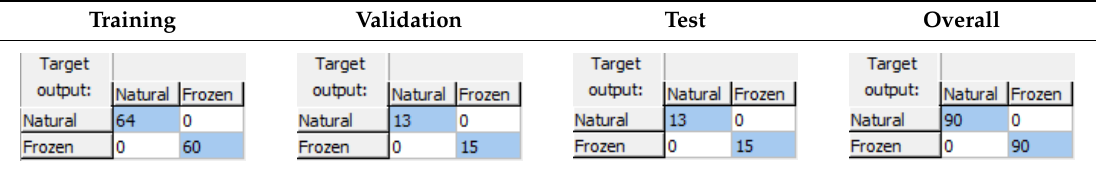
Table 1. Confusion matrices for freeze damage detection by the designed artificial neural network